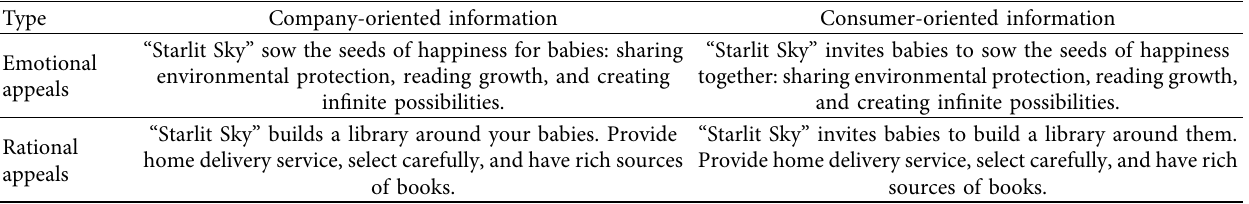
Table 3: Main text contents of experimental materials (research 2).